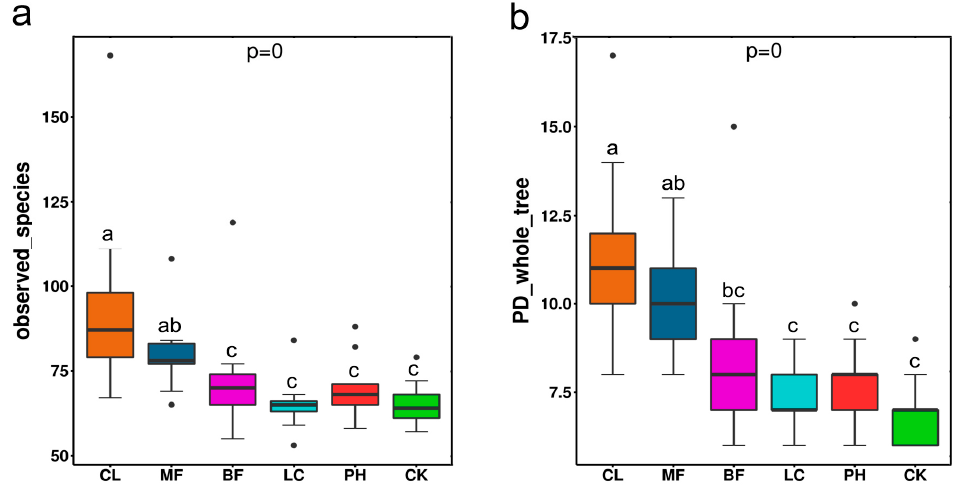
Figure 2. Map of intergroup ( a ) observed species index and ( b ) PD whole tree index statistics of airborne bacterial community diversity. The solid lines represent the median values; the top and bottom of the boxes represented the first and third quartiles. Whiskers include 95% of data. Different letters represent statistically significant differences ( p < 0.05). Table 1. Statistics on the data processing results.